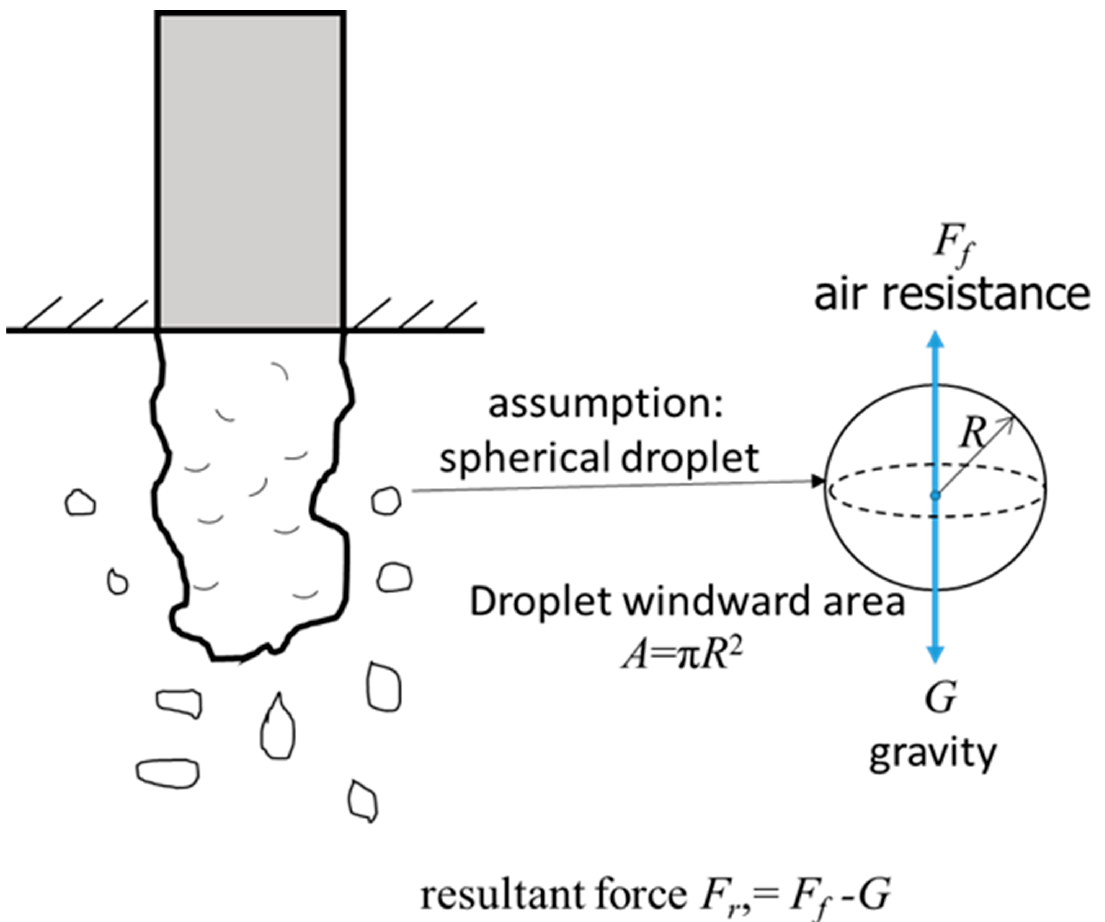
Figure 1. Hypothesis of spherical droplet.